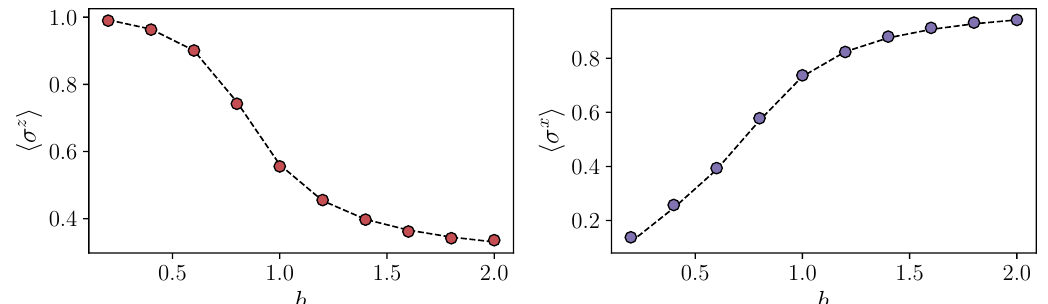
Figure 2: Reconstruction of the magnetic observables for the TFIM chain with N = 10 spins. We show the average longitudinal (left) and transverse (right) magnetization per site obtained by sampling from a trained RBM. The dashed line denotes the results from exact